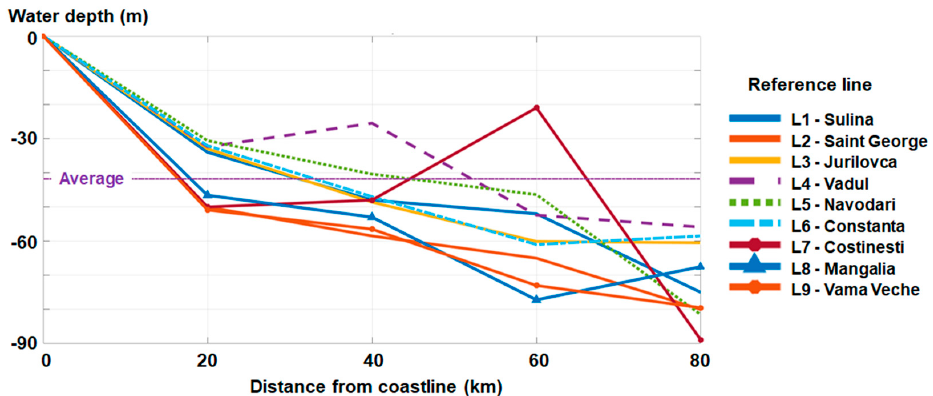
Figure 2. Variation of the water depth for each site considering various distances from the shore (0 km, 20 km, 40 km, 60 km, and 80 km).